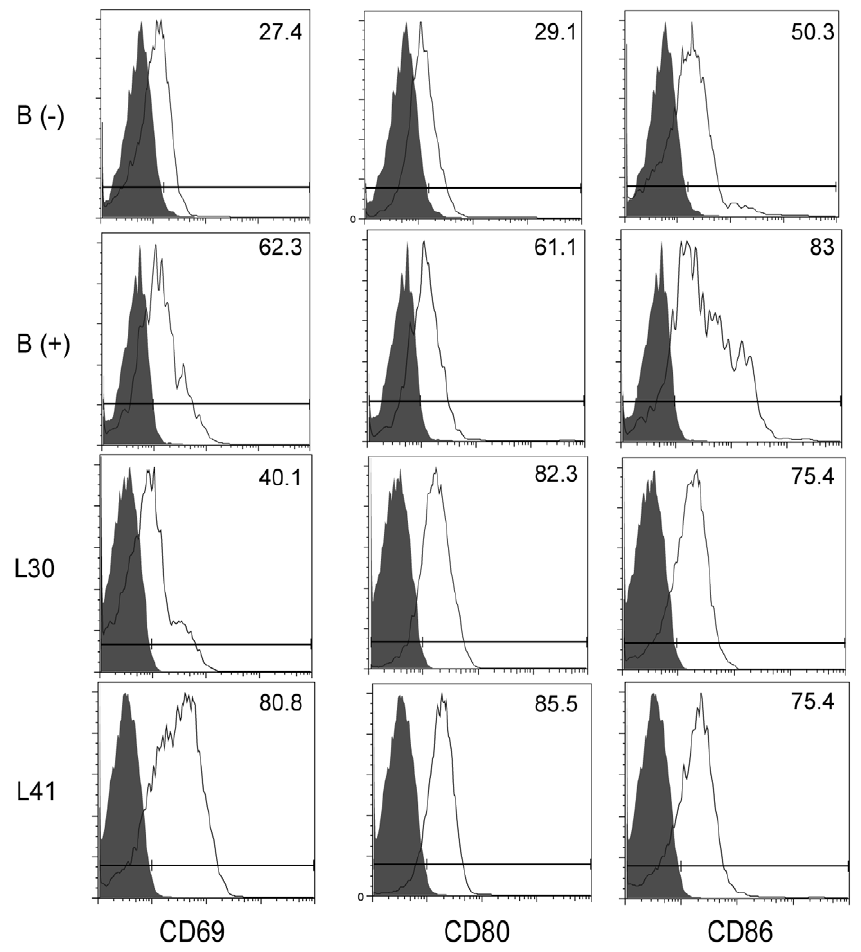
Figure 3. CLL cells express elevated levels of B cell activation markers. Unstimulated donor B cells, anti-IgM-activated donor B cells, or CLL cells were stained for CD69, CD80 or CD86 levels by FACS analysis. Grey filled curve shows the isotype control, open curve shows the specific antibody staining. One representative unactivated donor B cell sample (B-), one anti-IgM-activated B cell sample (B + ) and two CLL samples (L30 and L41) are shown. An expanded analysis of donor and patient samples is shown in Table S3.